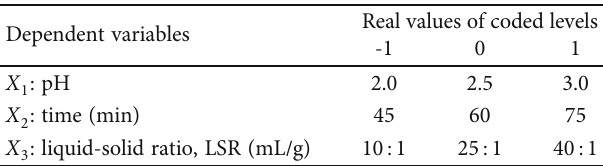
Table 1: Levels and code of variables chosen for the Box-Behnken